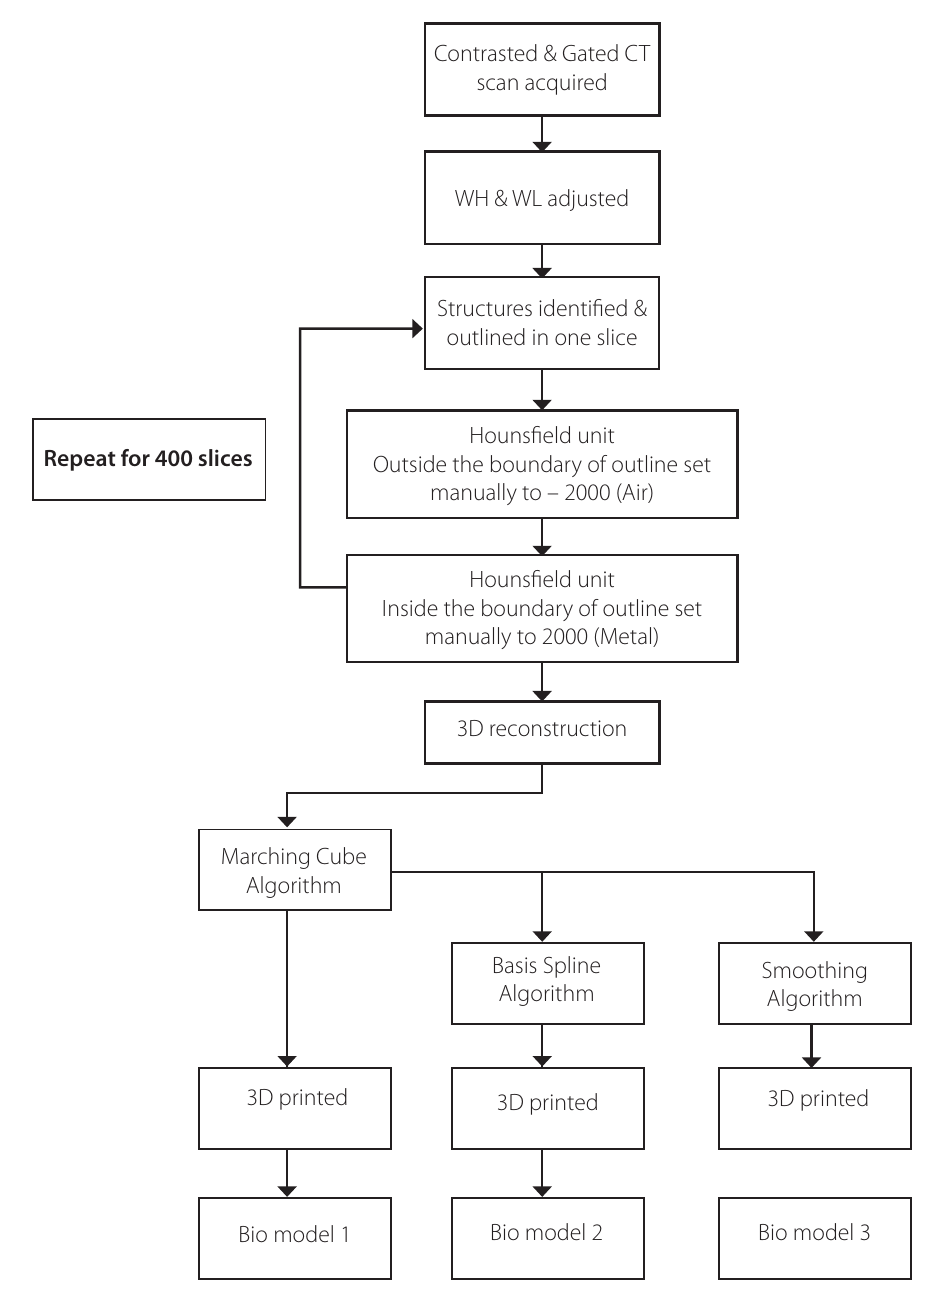
Fig. 1.1 - Process flow of the study. 3D=three-dimensional; CT=computed tomography; WH=wave height; WL=wavelength